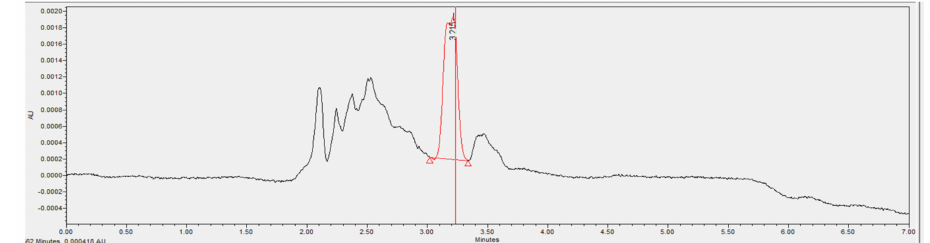
Figure 15. Chromatogram of the wastewater sample containing phenolic conjugate material processing Fe-C and A2O-MBBR system.